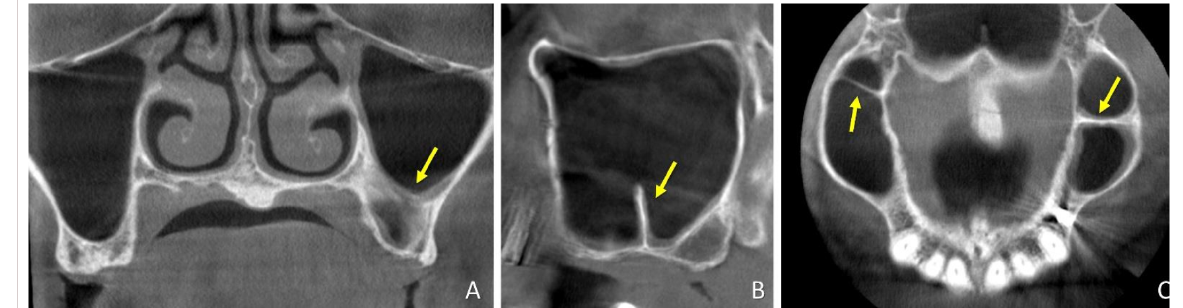
Figure 2. CBCT images illustrating the situation before surgery of a septa sinus. The yellow arrows indicate a septum in the left sinus in the ( A ) coronal, ( B ) lateral, and ( C ) axial views. In C, a septum is visible also in the right sinus.